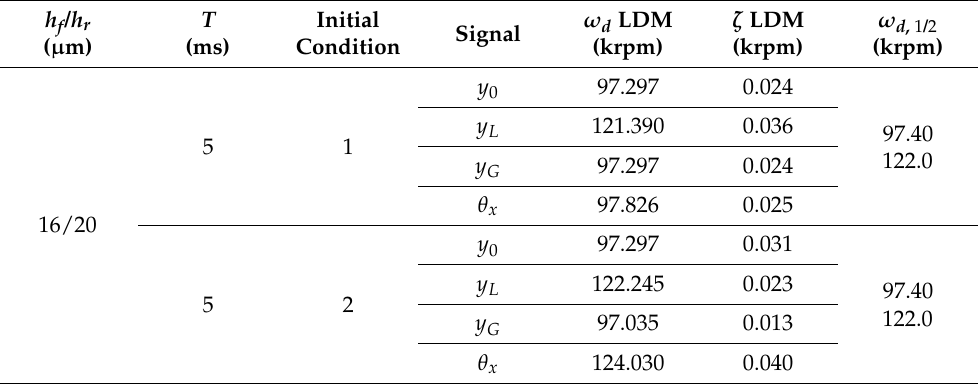
Table A4. Damped frequencies and damping factors resulting from FFT analysis and from LDM; p s = 0.9